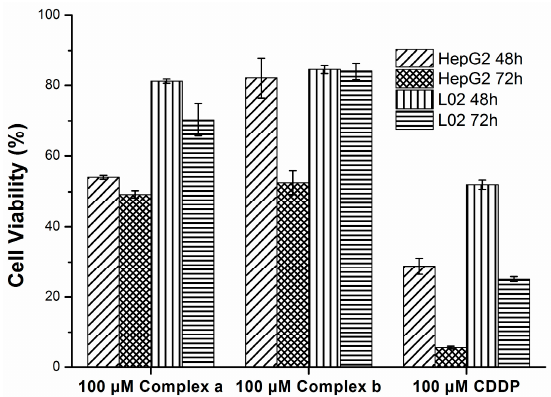
Figure 3. Inhibition effect of complexes a / b and CDDP on HepG2 and L02.